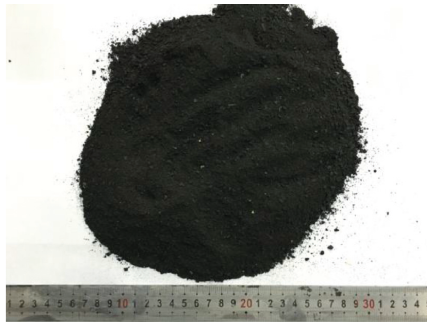
Figure 2: Rubber particles.